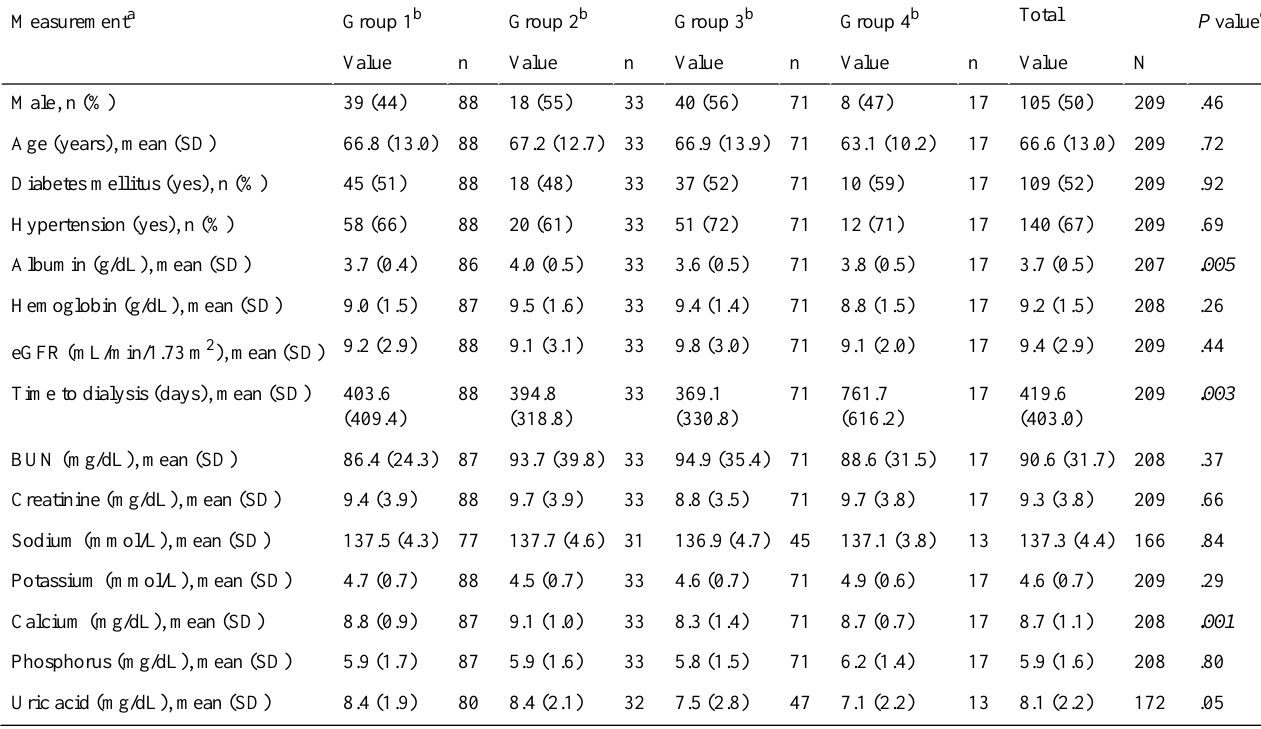
Table 1. Baseline demographic, clinical, and laboratory measurements by